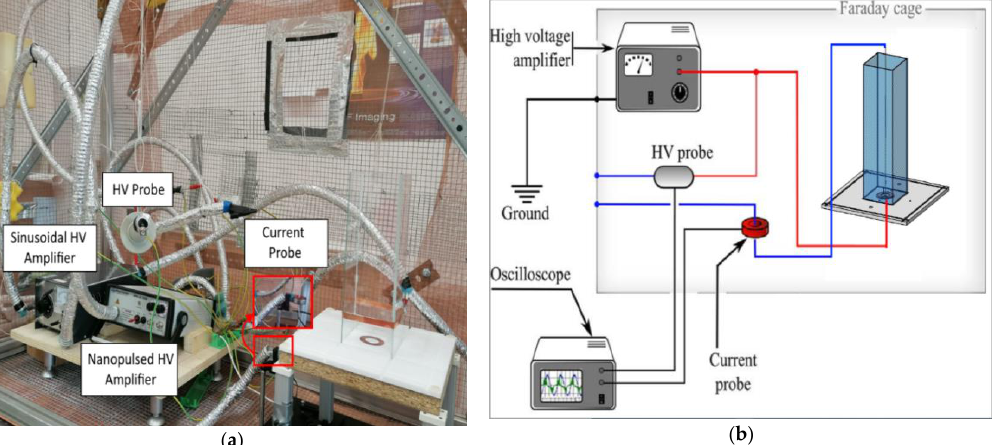
Figure 2. ( a ) Experimental setup; ( b ) Electrical